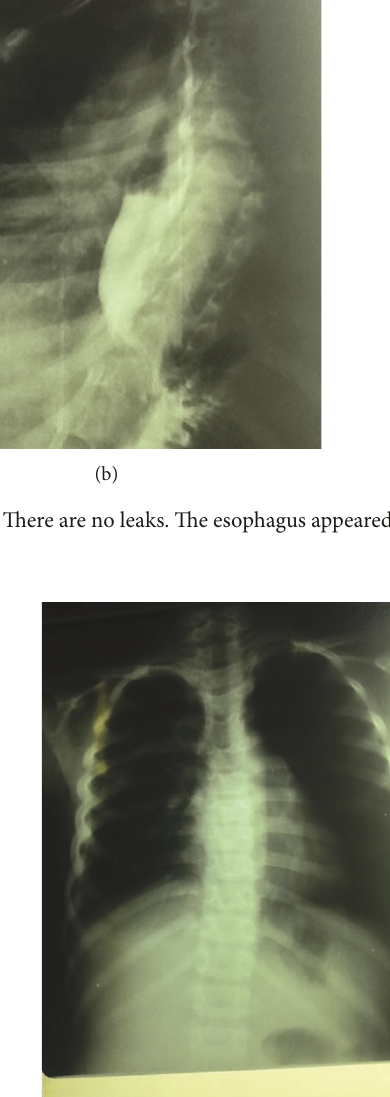
Figure 9: Chest X-ray: control at one year after both surgeries in the 6 Y/O